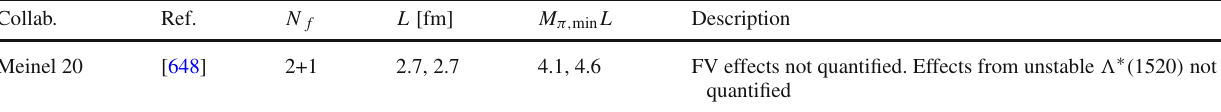
Table 162 Finite-volume effects in determinations of form factors for rare decays of beauty hadrons. Each L -entry corresponds to a different lattice spacing, with multiple spatial volumes at some lattice spacings. For actions with multiple species of pions, the lightest masses are quoted Collab.